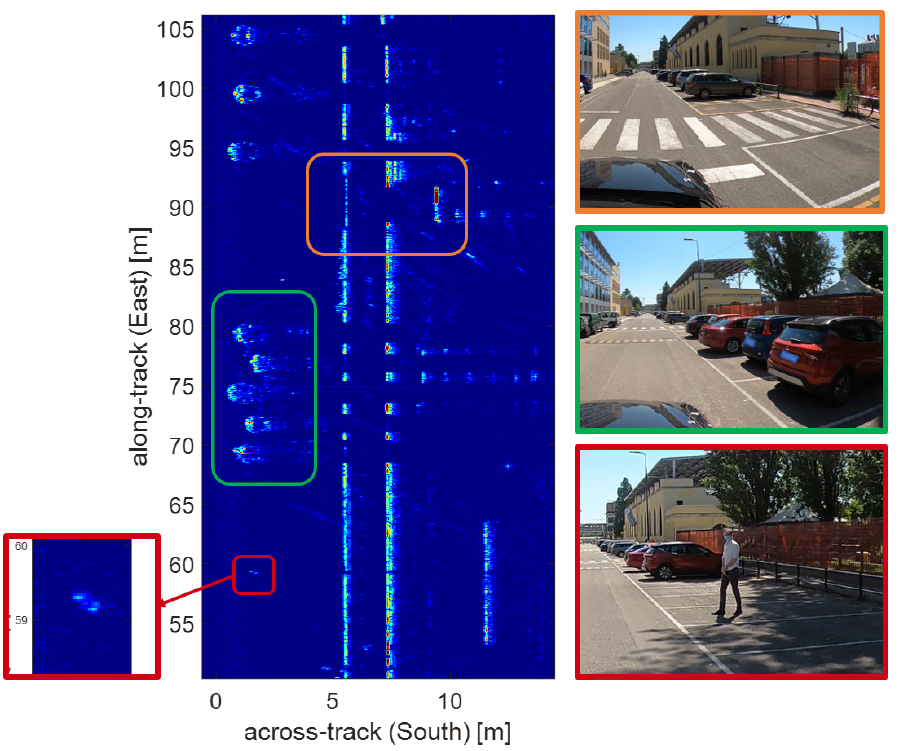
Figure 9. ( left ) Side-looking SAR image acquired over a 60m trajectory. Several details are highlighted with different colored box. ( right ) optical images corresponding to the colored box in the SAR image. Notice that the across-track axis starts from the right side of the car where the radar is